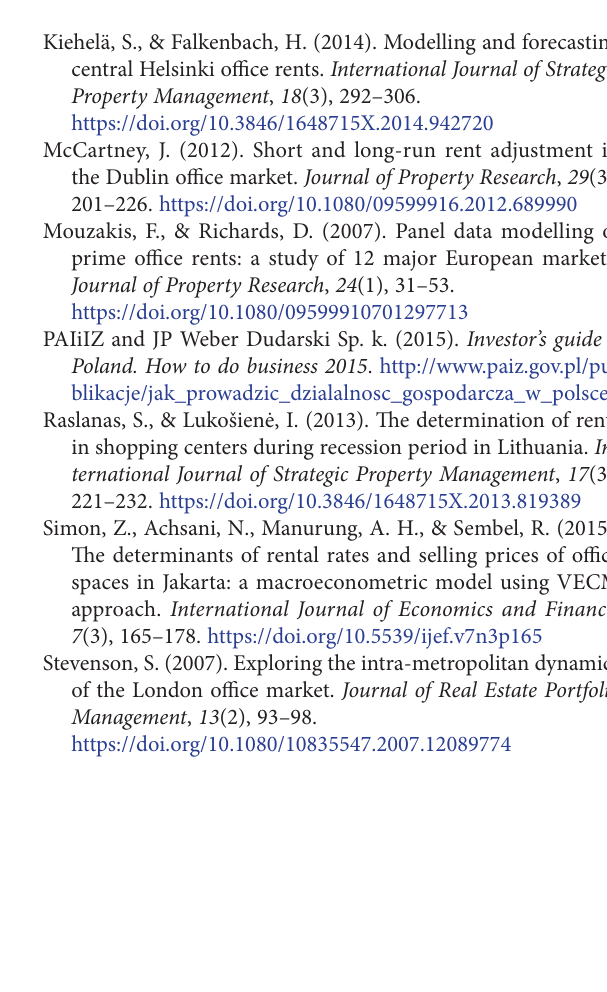
Table A1. The results of the ADF test for stationarity of variables used in the symmetric model (source: own study) Variable